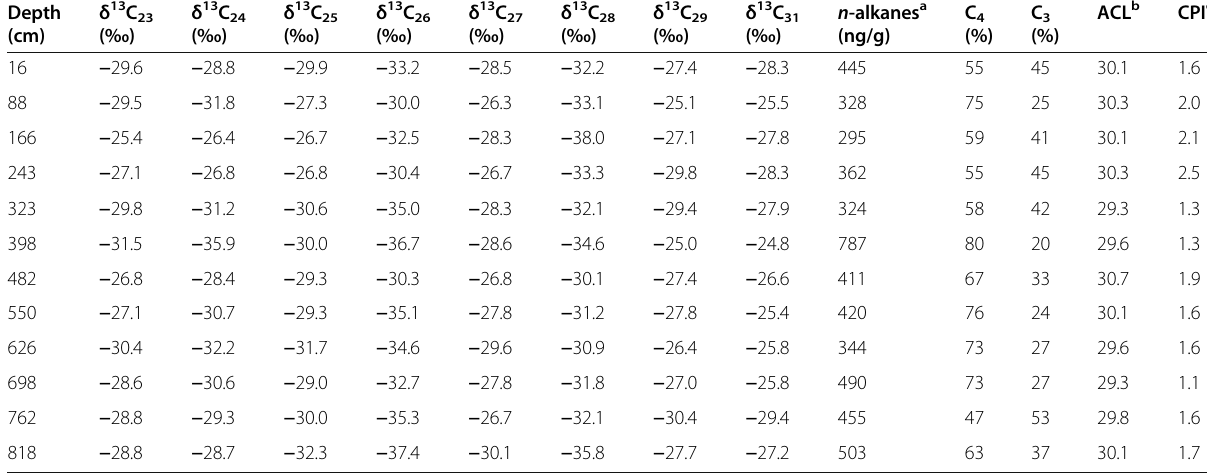
Table 1 Concentrations, δ 13 C values, and typical indices based on n -alkanes in the subsamples with different sediment depth of core R23. The relative contribution of long chain n -alkanes from C 3 and C 4 plants are calculated by carbon isotopes of the C 31 n -